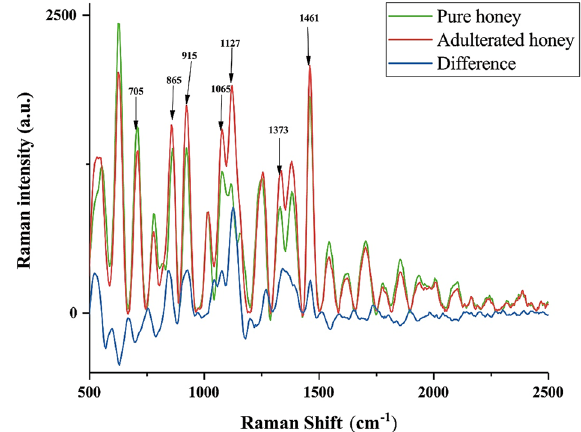
Figure 4. Mean spectra of samples.